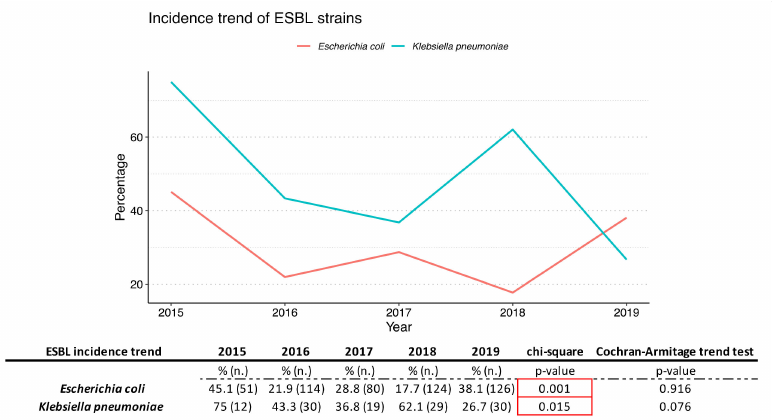
Figure 5. Incidence trend of E. coli producing ESBL and K. pneumoniae producing ESBL. % = % of resistance for each year; n . = number of total assays conducted for each